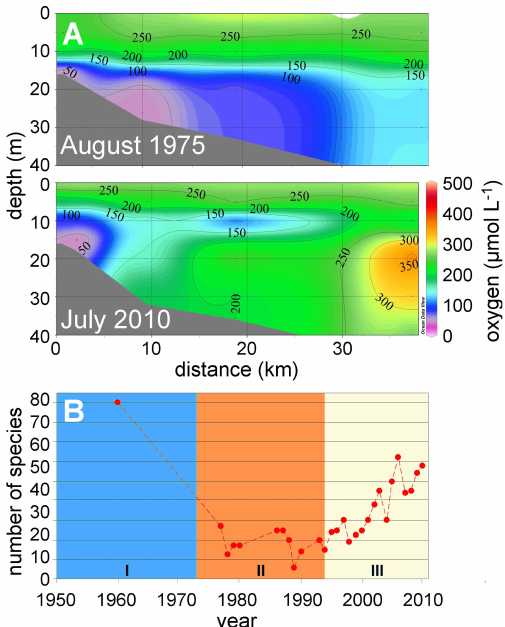
Fig. 20. ( A ) Distribution of oxygen concentration (µmolL − 1 ) in Romanian coastal waters (transect East Constanta) in August 1975 and July 2010. ( B ) Temporal changes in the species diversity of the total macrobenthic community in the Romanian pre-Danubian sector (Period: I – pre-eutrophication, II – eutrophication, III – post- eutrophication).